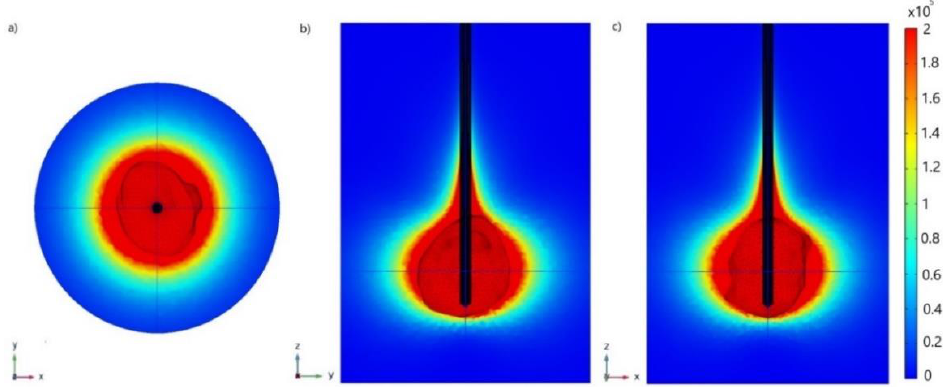
Figure 7. ( a ) x–y , ( b ) y–z , and ( c ) x–z cut planes of the total power dissipation density (expressed in W/m 3 ) calculated for the liver tumor [70] (plotted as triangulated surface) exposed to microwave frequency of 2.45 GHz and input power of 13 W after 600 s.